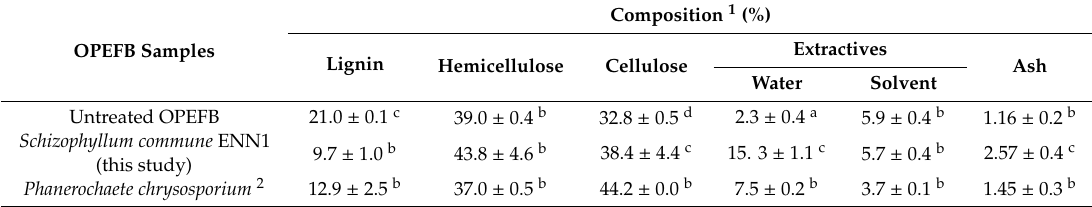
Table 1. Comparison of the composition of untreated and biologically pretreated OPEFB by Schizophyllum commune ENN1 and Phanerochaete chrysosporium after 14 days of incubation.